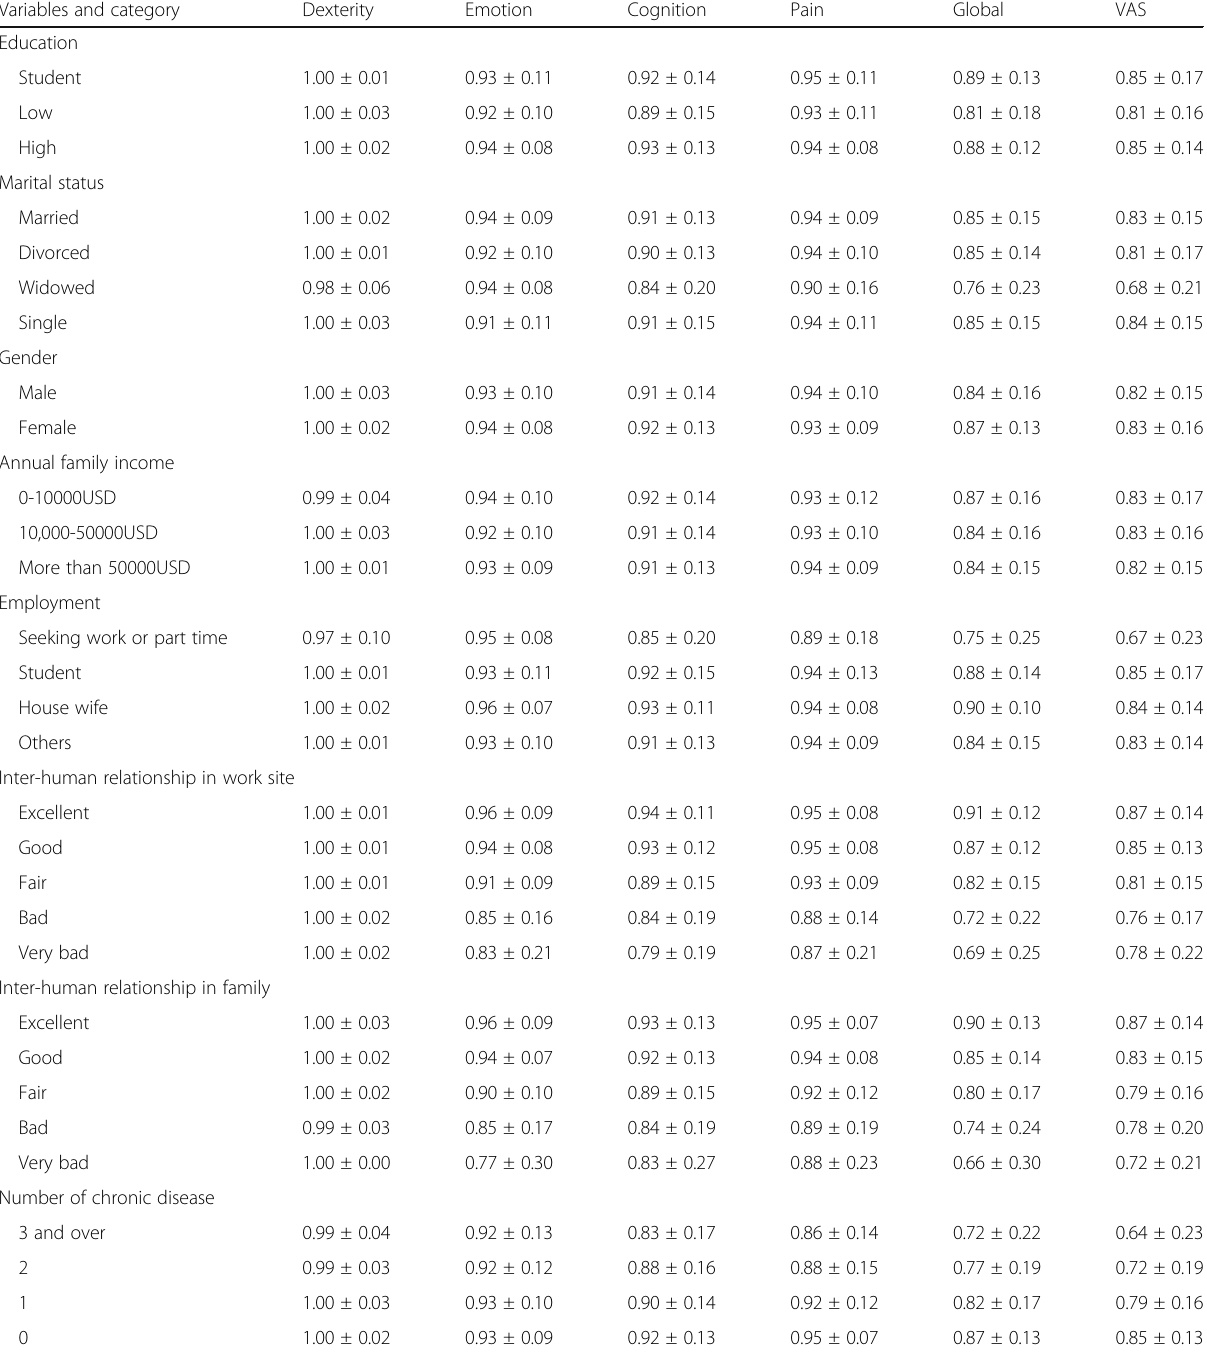
Table 5 Mean utility scores (single attribute, multiattribute global HUI3) and VAS score by personal characteristic variables Variables and